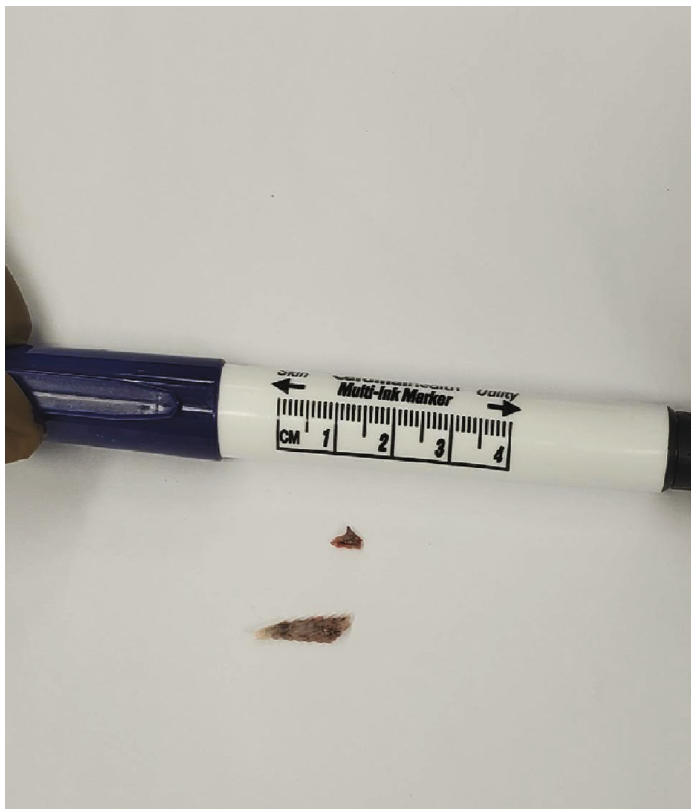
Figure 5: Dorsal spines of hardhead cat fi sh (Ariopsis